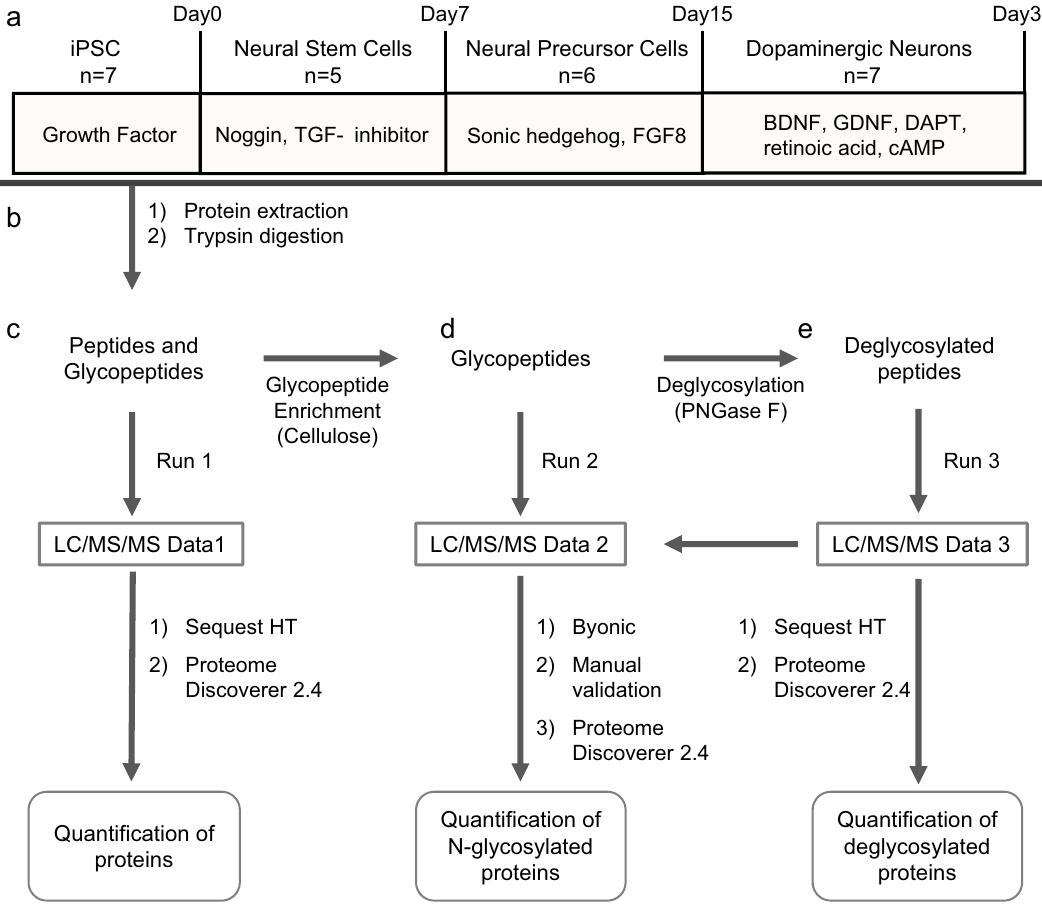
Figure 1. The workflow of the proteomic and glycoproteomic analyses. ( a ) Neuronal differentiation of iPSC. ( b ) Protein extraction and trypsin digestion. ( c ) Quantitative proteomic analysis. Label-free peptides and glycopeptides were analyzed by LC/MS/MS. ( d ) Quantitative glycoproteomic analysis. Cellulose-enriched glycopeptides were analyzed by LC/MS/MS. ( e ) Quantitative deglycosylated proteomic analysis. Peptide N-glycosidase F-treated glycopeptides were analyzed by